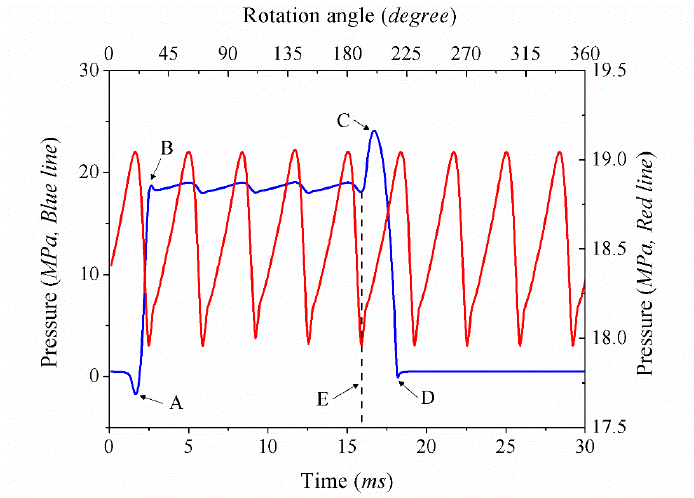
Figure 6. Simulation variations in the chamber pressure and outlet pressure.